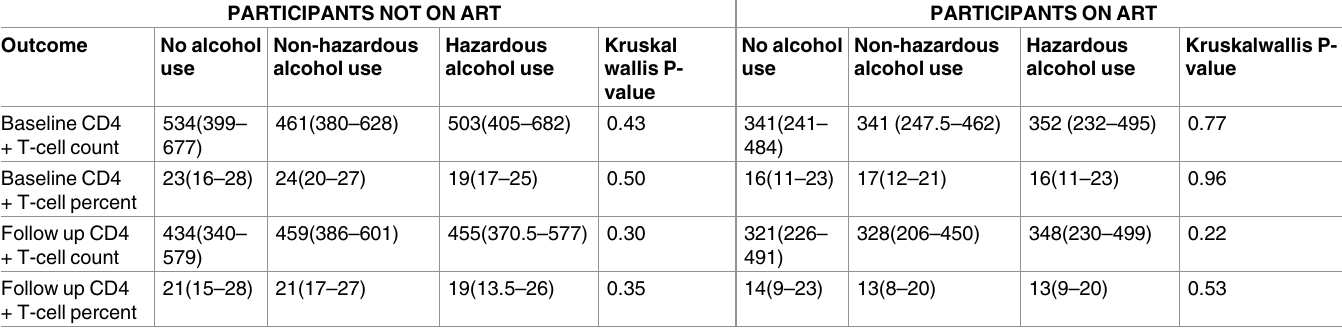
Table 2. Comparison of median and interquartile range of CD4+ T-cell count and CD4 percentage by reported alcohol use category at baseline (n = 1423) and at all follow up visits (n = 1361) of PLHIV enrolled in the alcohol study at the Infectious DiseasesInstitute, Kampala